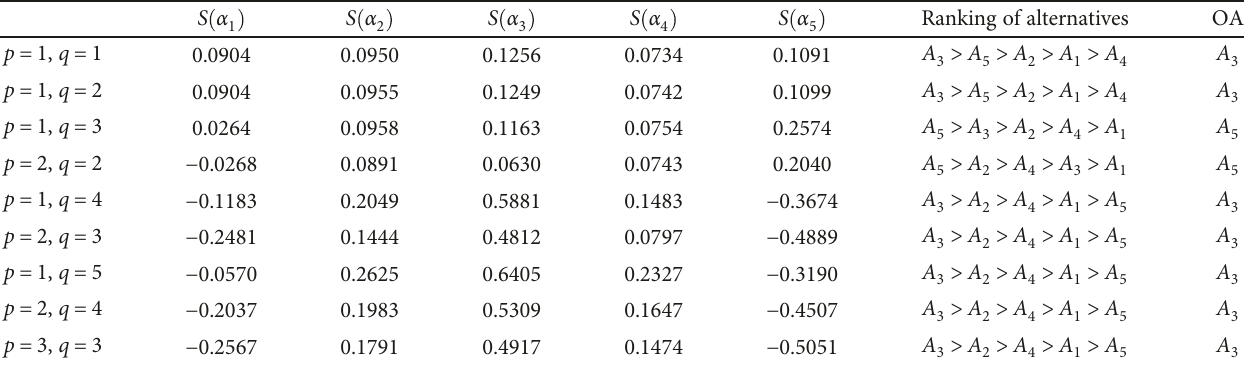
Table 5: Results of di ff erent p and q considering